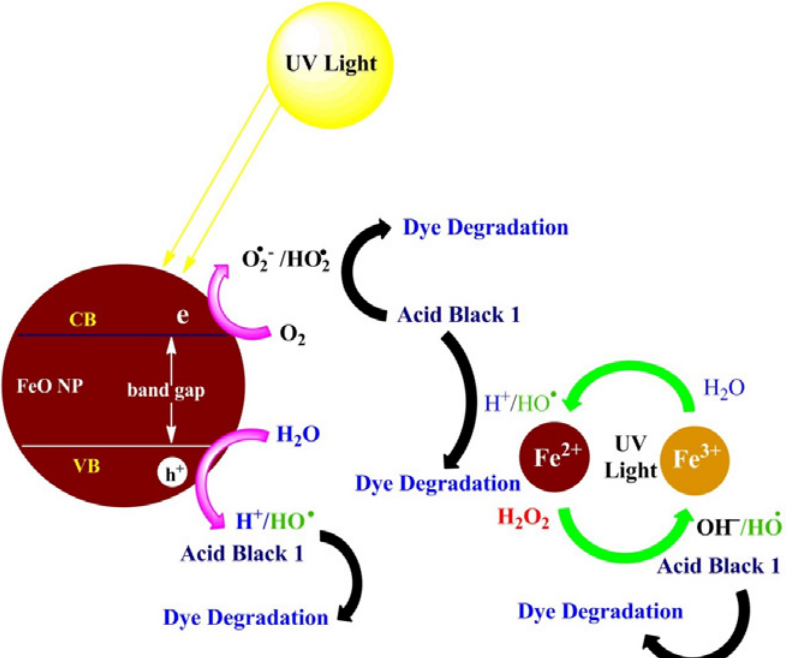
Fig.11. Proposed mechanism for AB1 degradation by photo-Fenton process and photocatalytic degradation over FeO nanoparticles under UV